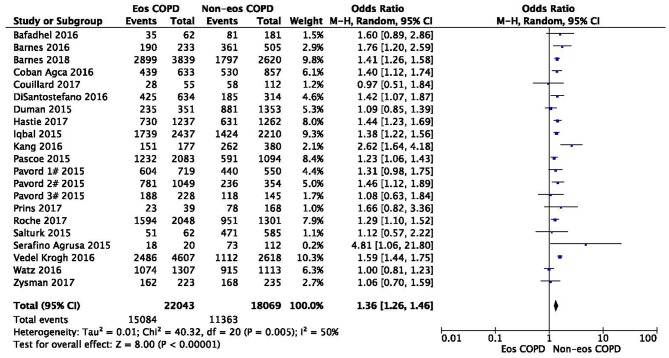
Comparison of gender character between eosinophilic and non-eosinophilic COPD. M.-H., Mantel-Haenszel; CI, confidence interval; Eos, eosinophilic; Non-eos, non-eosinophilic; COPD, chronic obstructive pulmonary disease.